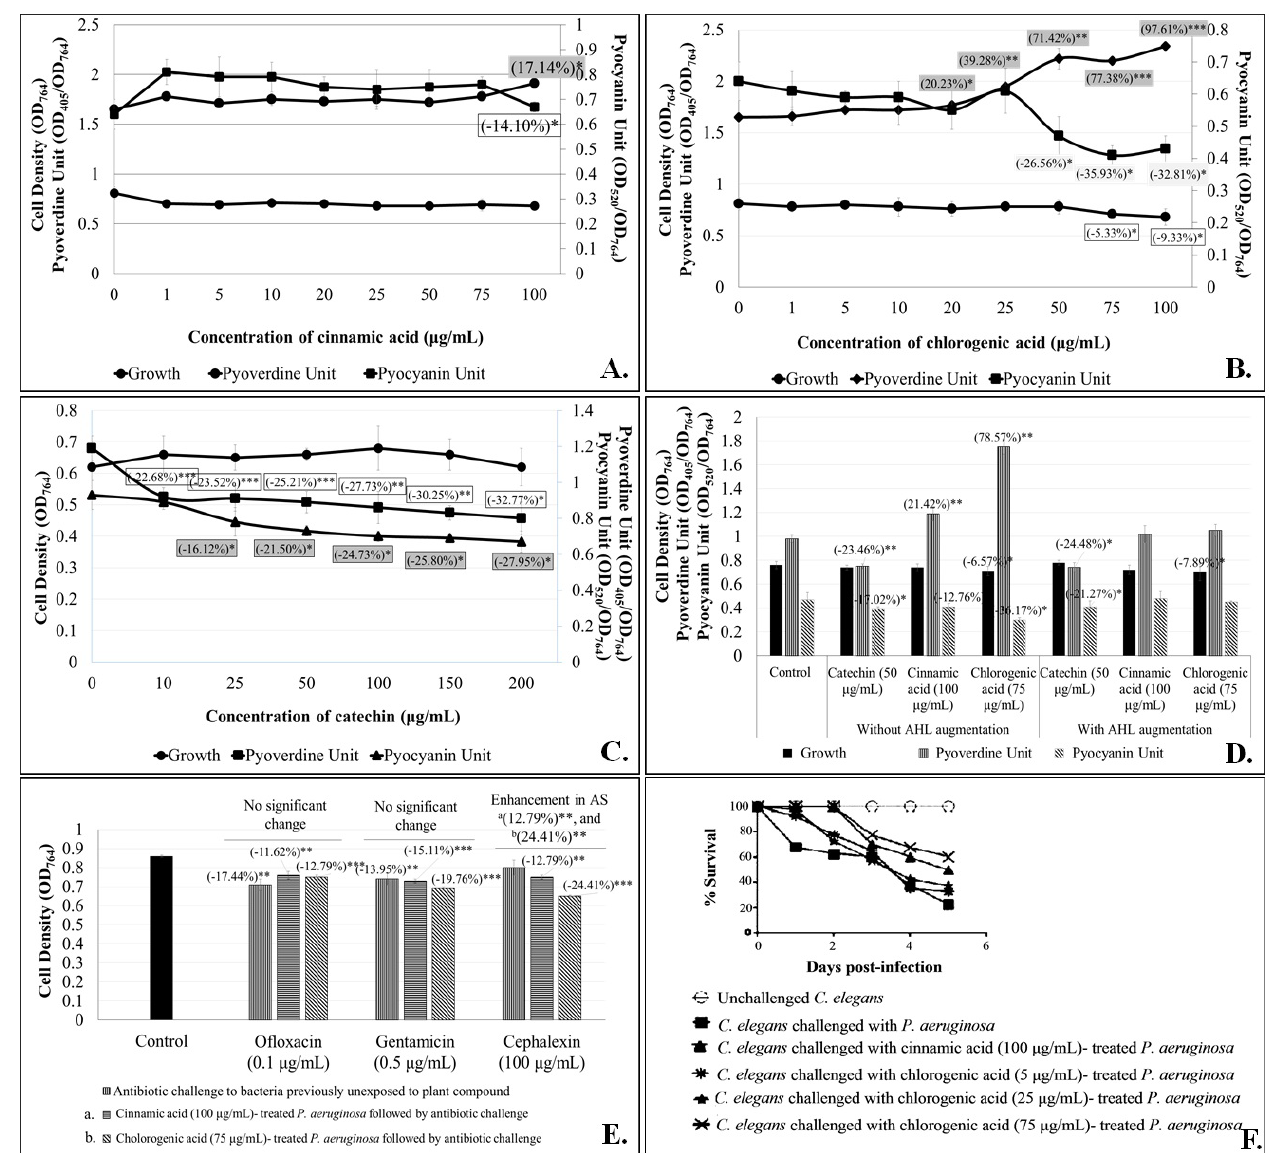
Figure 7. Effect of pure compounds on QS-regulated traits of P. aeruginosa. Bacterial growth was measured as OD ; OD of pyoverdine 764 was measured at 405 nm, and Pyoverdine Unit was calculated as the ratio OD /OD (an indication of pyoverdine production per unit of 405 764 growth), Pyocyanin Unit was calculated as the ratio OD /OD (an indication of pyocyanin production per unit of growth). ‘Control’ in this 520 764 figure is the vehicle control (0.5%v/v DMSO), which did not exert any effect on growth and pigment production of P. aeruginosa . ( A ) Effect of cinnamic acid on growth and QS-regulated pigment production in P. aeruginosa . ( B ) Effect of chlorogenic acid on growth and QS-regulated pigment production in P. aeruginosa. ( C ) Effect of catechin on growth and QS-regulated pigment production in P. aeruginosa . ( D ) Cinnamic acid and chlorogenic acid act as signal-supply inhibitors against P. aeruginosa , whereas catechin acts as a signal-response inhibitor . ( E ) P. aeruginosa receiving pre-incubation with cinnamic acid or chlorogenic acid becomes more susceptible to cephalexin. ( F ) Pre-treatment of P. aeruginosa with cinnamic acid or chlorogenic acid reduces its virulence towards C. elegans: Catechin (50 µg/ml) and gentamicin (0.1 µg/ml) employed as positive controls conferred 100% and 80% protection on worm population respectively; DMSO present in the ‘vehicle control’ at 0.5%v/v did not affect virulence of the bacterium towards C. elegans; DMSO (0.5%v/v) and compounds at tested concentrations showed no toxicity towards the worm. * p <0.05, ** p <0.01, *** p <0.001; AS, Antibiotic susceptibility; QS, Quorum